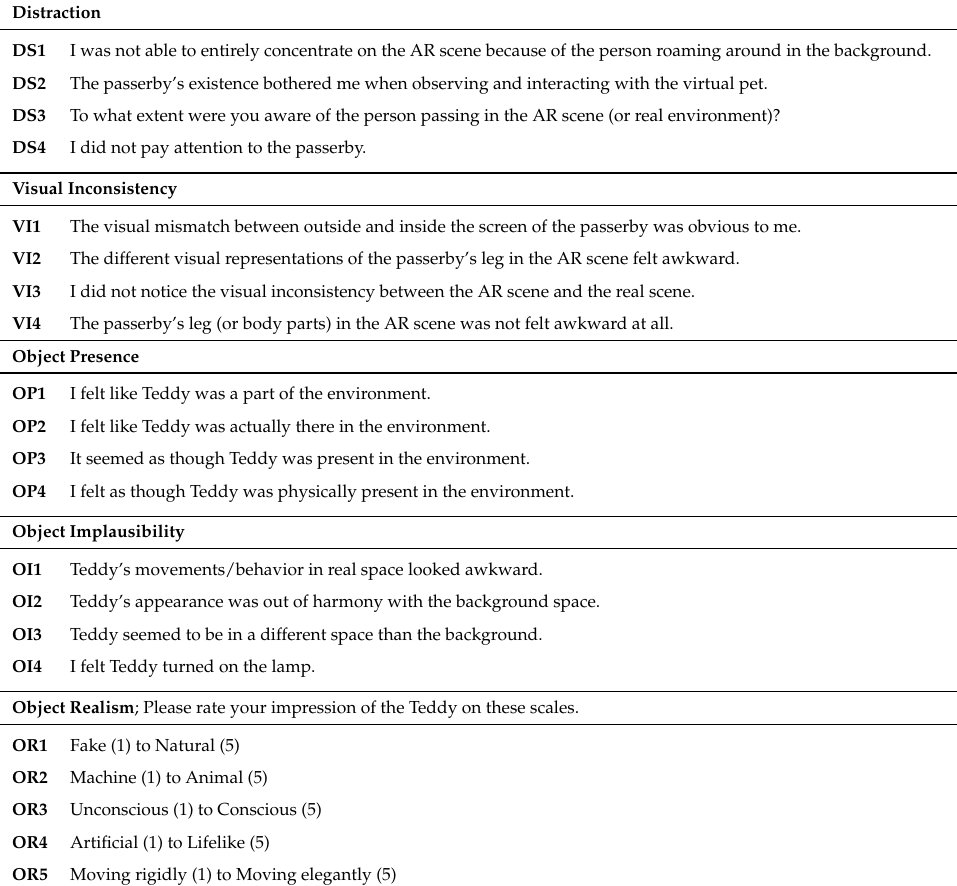
Table 3. The questionnaire used to assess the users’ perception of visually diminished pedestrian and the virtual contents. Distraction, visual inconsistency, object presence, and object